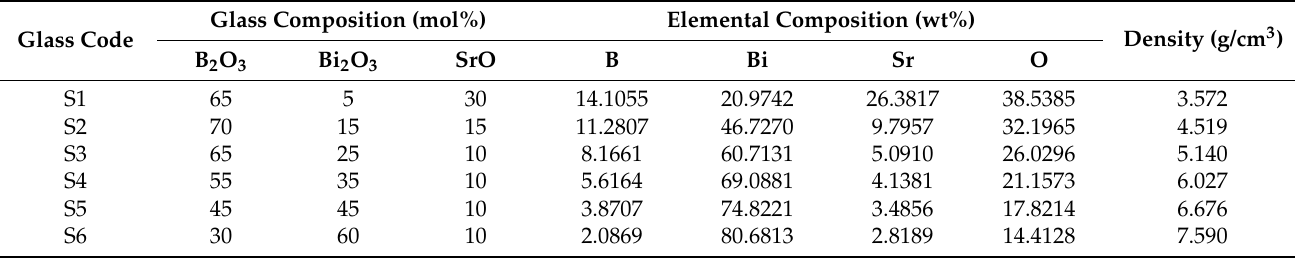
Table 2. Chemical composition (mol%) and elements (wt%) present in the selected B 2 O 3 -Bi 2 O 3 -SrO glasses, including their density [44].